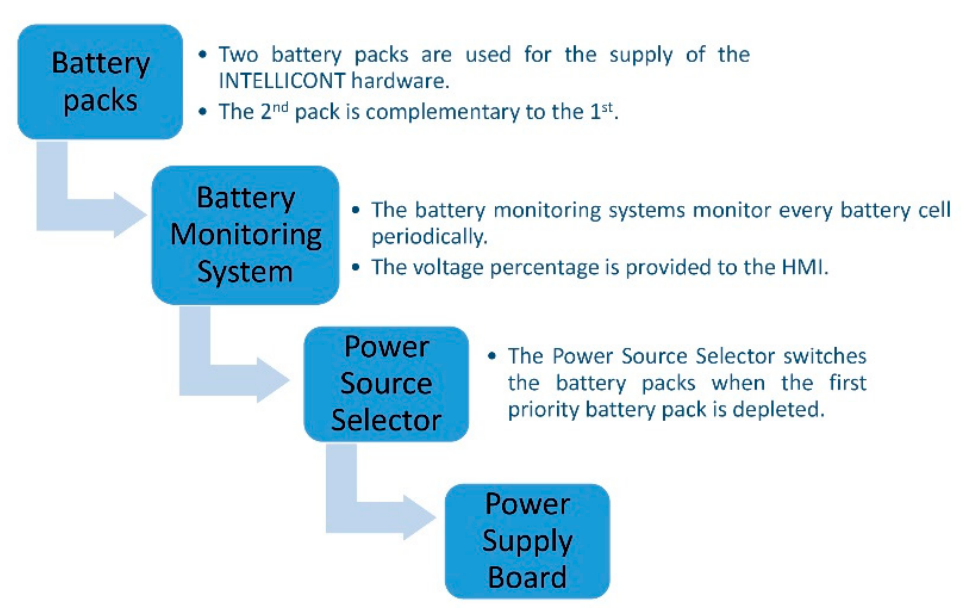
Figure 6. Battery supply and management system.